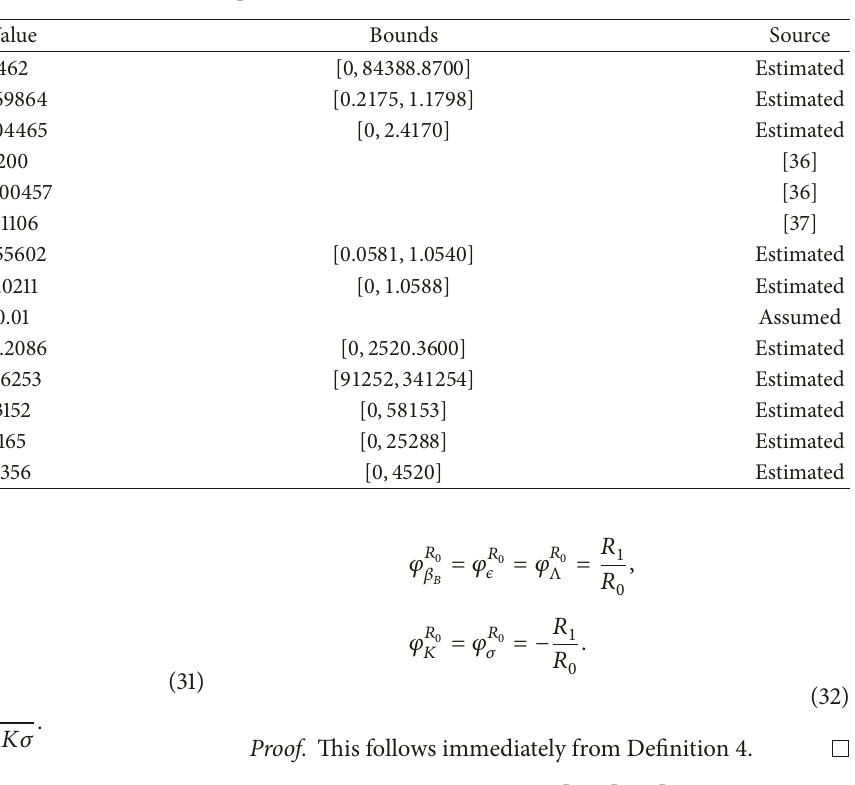
Table 3: Estimated parameter